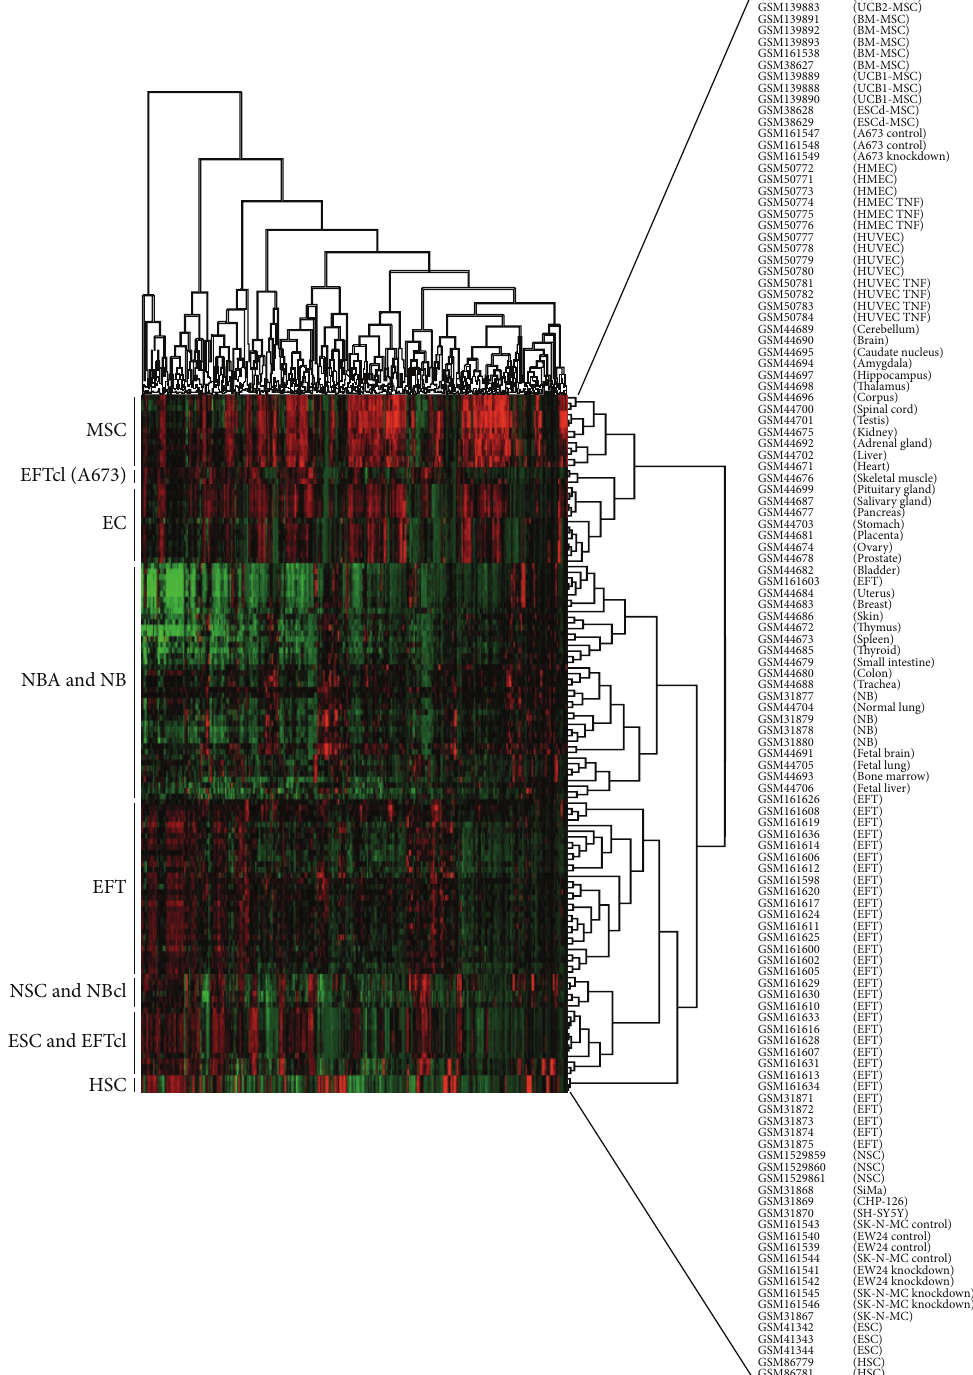
Figure 5: The stem cell signature of Ewing sarcoma biopsies. DNA microarray cel files from stem cells were processed as described in